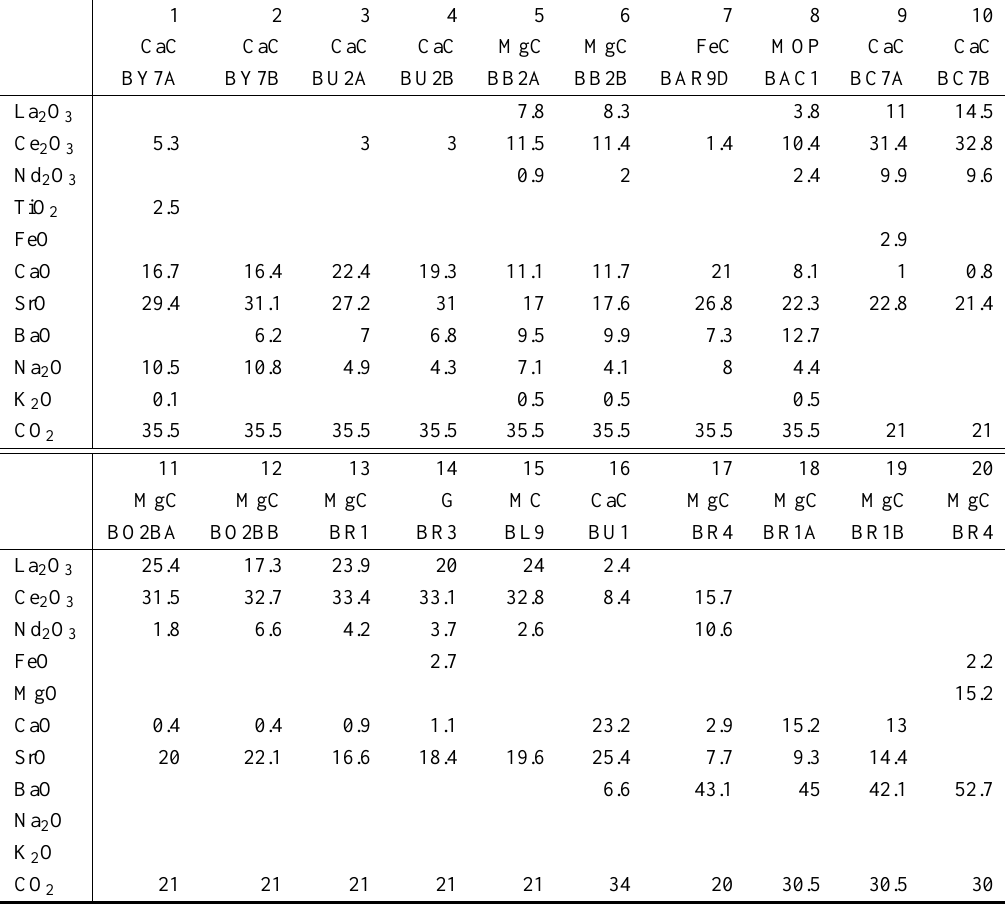
Representative REE carbonate analyses (burbankite, 1-8; ancylite, 9-15; carbocernaite, 16; huanghoite, 17; baritocalcite, 18-19; norsethite, 20) of Araxá rocks. For rock abbreviations